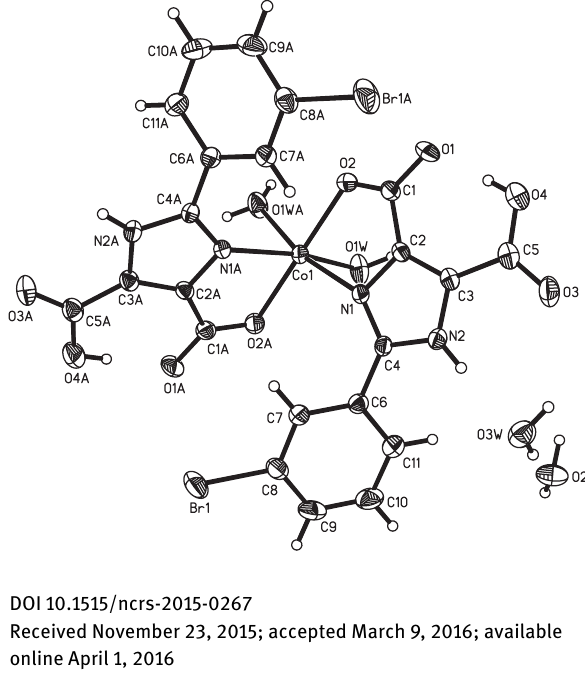
Table 1: Data collection and handling.